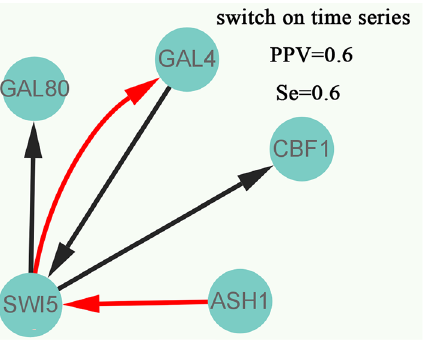
Figure 5. Reverse engineering of the IRMA gene network from time series experimental data using the ODE- based